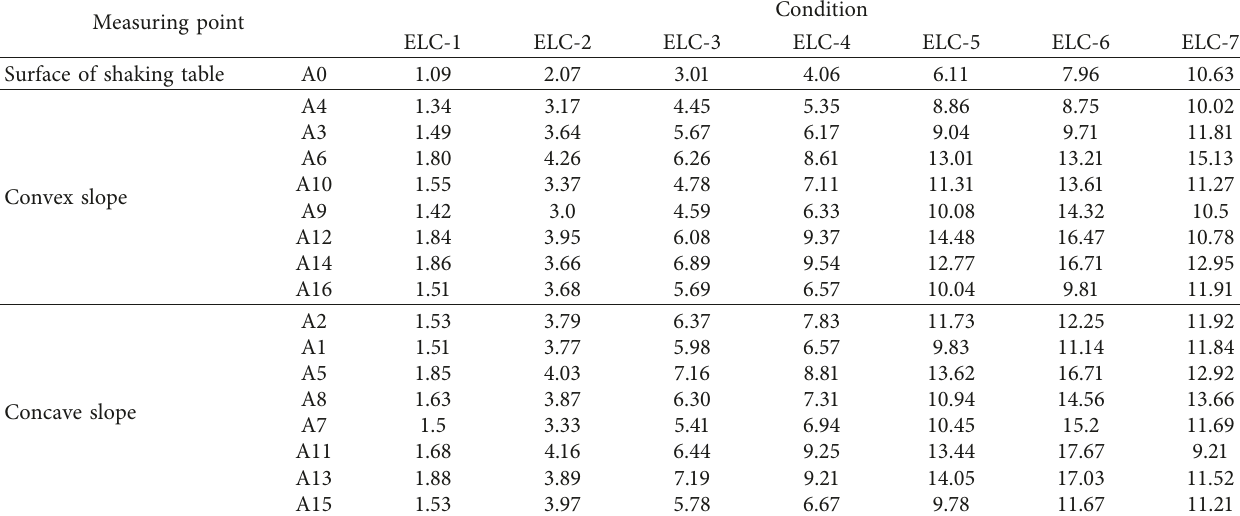
Table 7: Peak acceleration of each measuring point under El Centro waves (m/s 2